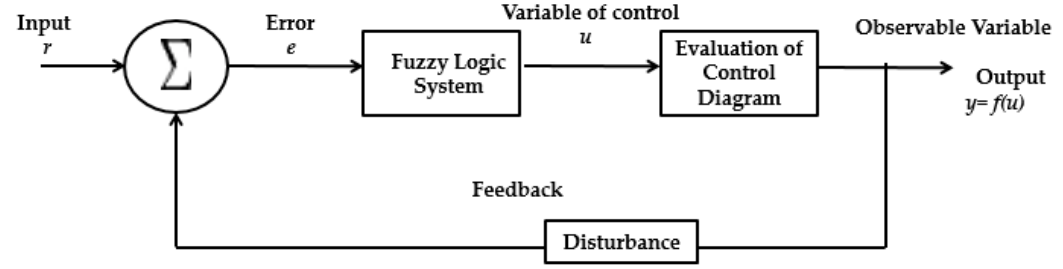
Figure 7. General representation of a FLC.